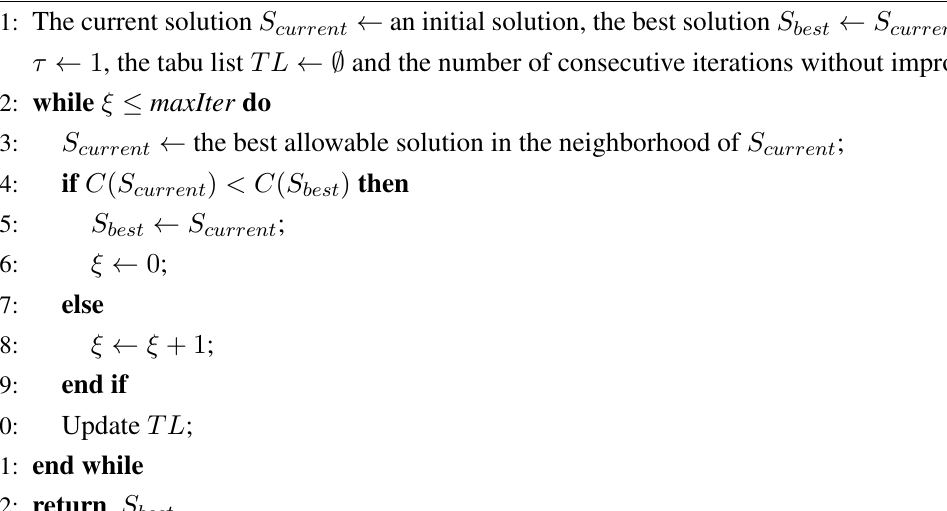
Algorithm 1 The tabu search